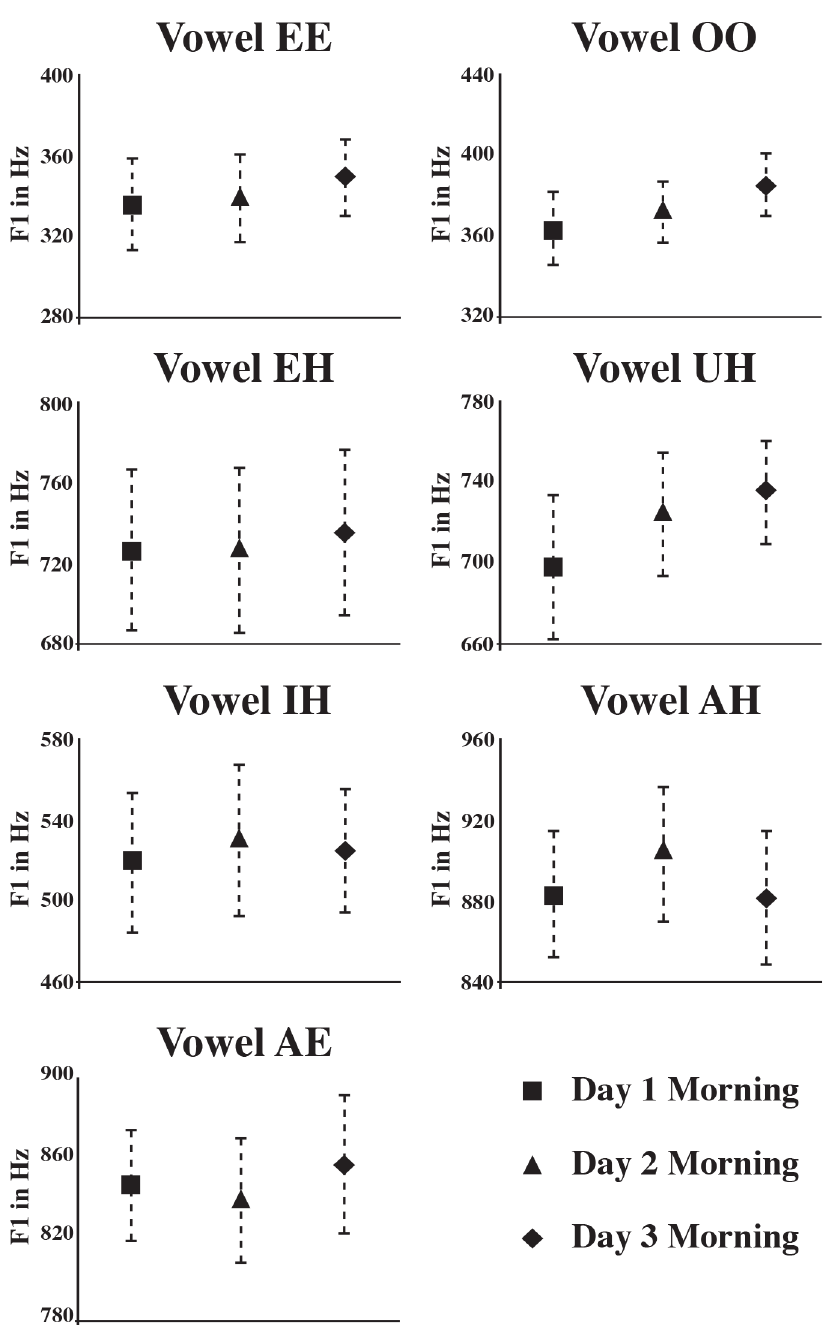
Fig 2. Morning F1 mean values across subjects with error bars showing standard error for each vowel for each day tested. As indicated by an average morning standard error of 29.96 Hz, there is high precision in isolated citation-form vowel production across